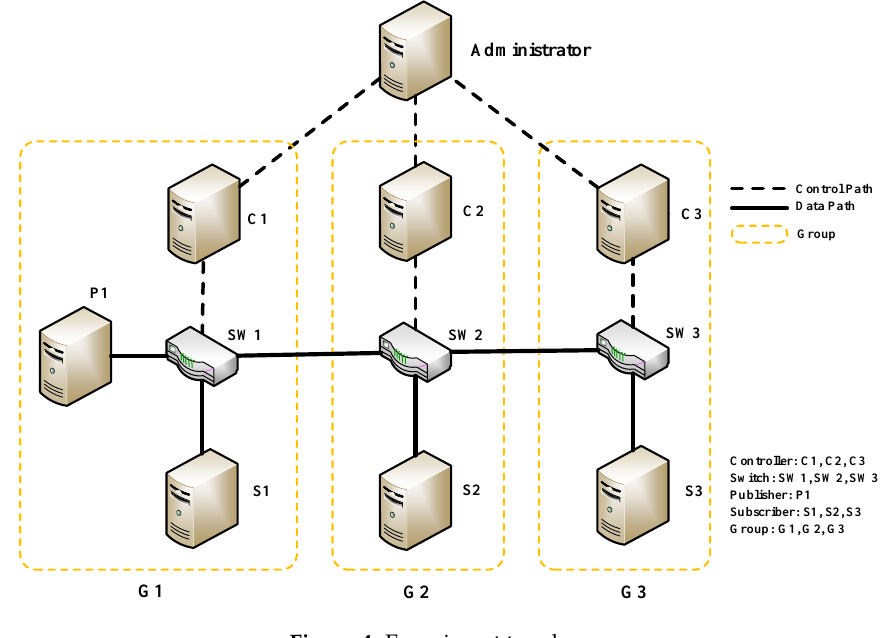
Figure 4. Experiment